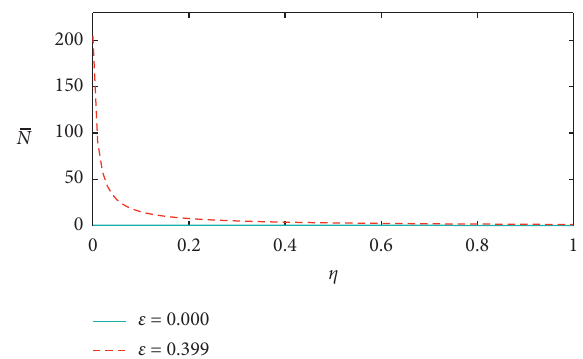
Figure 11: Plots of the mean number of photon pairs (equation (35)) versus η for A � 10, κ � 0 . 8, n th � 0 . 15 and for different values of ε .